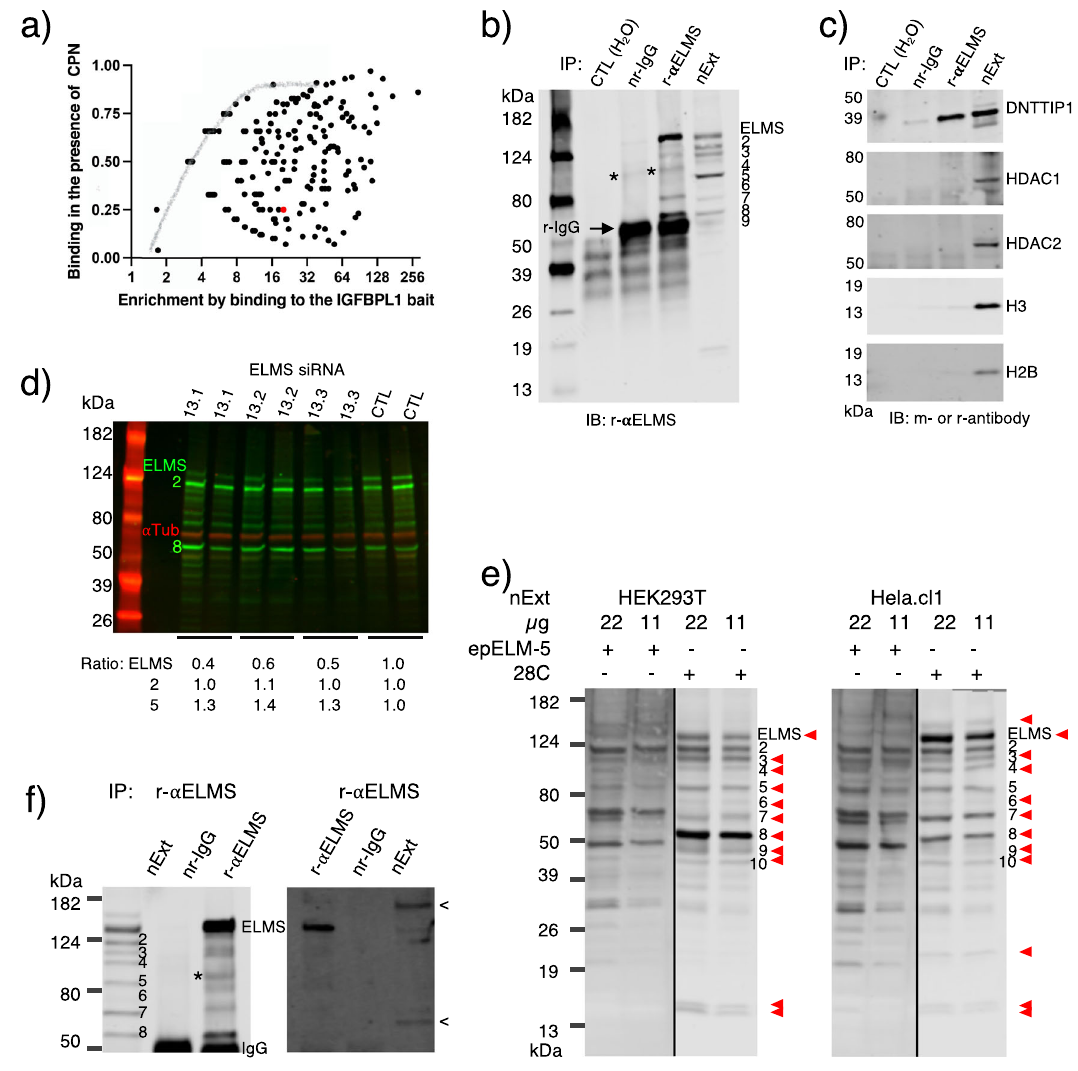
Fig. 1 Immunoprecipitation (IP) with the rabbit anti-ELMSAN1 antibody. a ELMSAN1 ’ s binding to the IGFBPL1 bait is strongly inhibited by the KDM2A CPN domain. ELMSAN1 is shown by a red dot. Values on a are calculated from data of the previous publication: (gel slices #1 – 4 of Fig. 5a; -CPN nuclear extract of 5c) 16 . Y axis shows residual binding level of proteins in the presence of the CPN domain by ratio (C b + CPN /C b-CPN ), and X axis shows enrichment of proteins by fold [(C/SOC) b-CPN /(C/SOC) e-CPN ] with the nuclear extract lacking the CPN domain. (C/SOC) b-CPN and (C/SOC) e-CPN are concentration of a protein bound to the bait and the protein in the nuclear extract, respectively. Data for Y < 1 are plotted. b, c IP of nuclear extract with a rabbit anti- ELMSAN1 antibody. The IP is visualized by IB. nr-IgG (normal rabbit IgG), r- α ELMS rabbit (anti-ELMSAN1 antibody), nExt (nuclear extract input). An asterisk (*) indicates noise derived from IgG. This symbol (*) was used throughout this report to indicate noise. The host of the antibodies used for the IB is either rabbit (r) or mouse (m). d Knockdown of the ELMSAN1 gene. Three different siRNAs and one universal negative control were added to 10 nM in duplicate cultures, respectively. Ef fi cacy of the knockdown is estimated by dividing the level of ELMSAN1 with that of α -tubulin. e Inhibition of the rabbit ELMSAN1 antibody by the 6x His-tagged epitope (epELM-5). Twenty micrograms of epELM-5 bound to PVDF, and the control (28C) bound to PVDF (see Supplementary Fig. 1) were incubated in the IB solution that has both the r-anti-ELMSAN1 antibody and a sample PVDF membrane. The red arrowhead indicates the band for which binding of the antibody was reduced. f Identi fi cation of ELMSAN1 with a mouse monoclonal anti-ELMSAN1 antibody. PAGE separated immunoprecipitates were transferred to PVDF and probed with the rabbit (left) and the mouse monoclonal anti-ELMSAN1 antibody (right). Arrow (<) shows unidenti fi ed bands detected with the mouse antibody in the nuclear